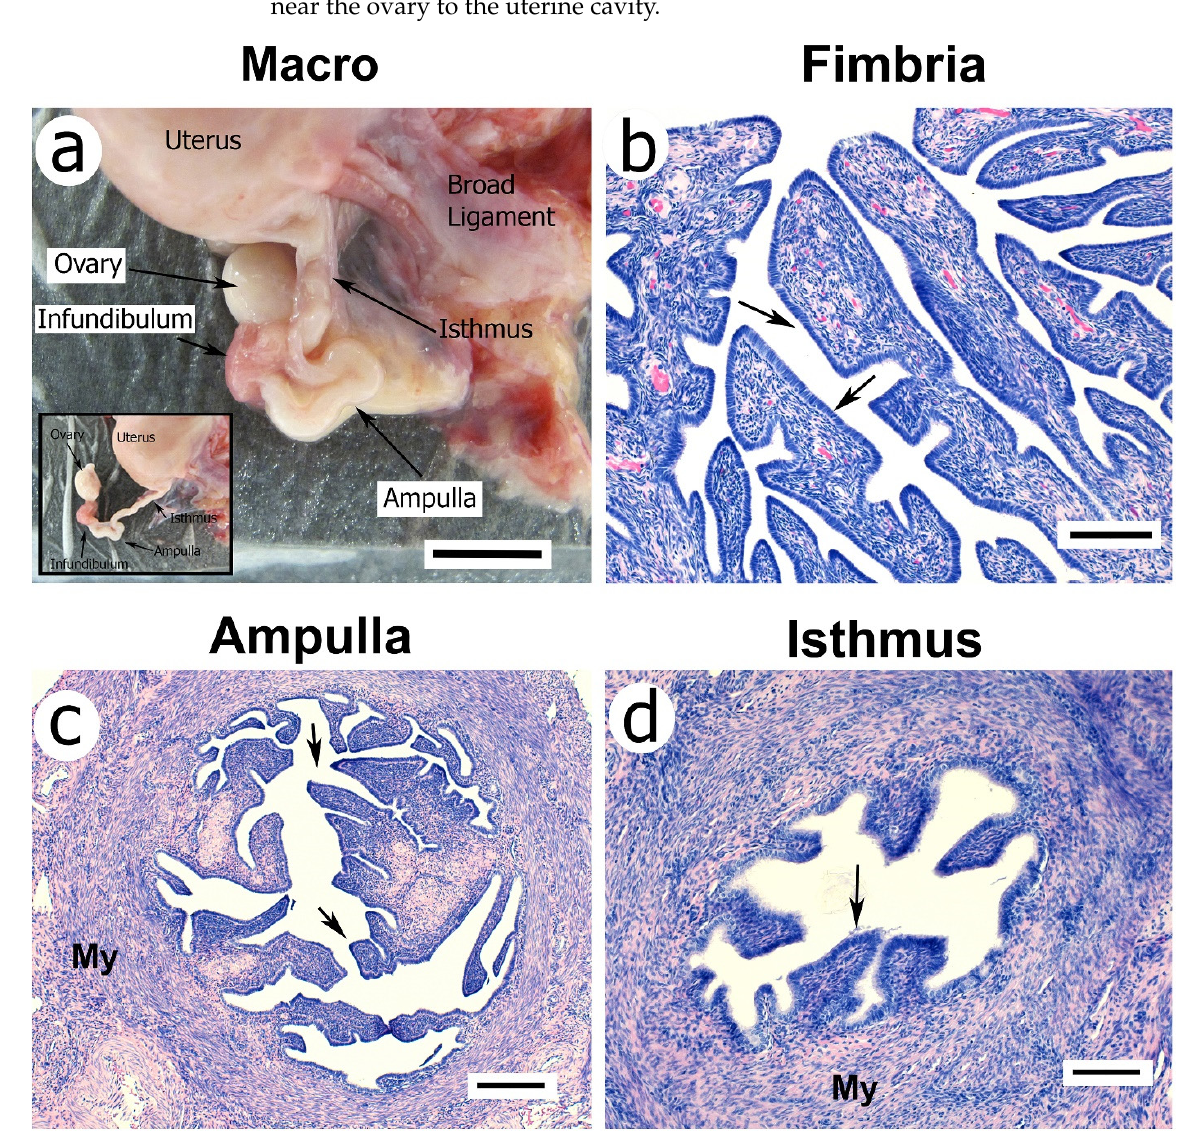
Figure 2. A photograph of the macaque reproductive tract ( a ) showing the uterus, oviductal in- fundibulum, ampulla, and isthmus. The inset shows the fallopian tube dissected free of peri-ovarian adipose and ligaments. Note the attachment of the fimbria to the ovary. Panels ( b – d ) show paraffin- embedded and hematoxylin-eosin stained (H&E) sections of the infundibulum fimbria ( b ), ampulla ( c ), and isthmus ( d ) from a rhesus macaque in the luteal phase of the menstrual cycle. Arrows show the cuboidal epithelium of the endosalpinx. My = myosalpinx. Scale bar in ( a ) is 1 cm. Scale bars in ( b – d ) represent approximately 100 μ m.